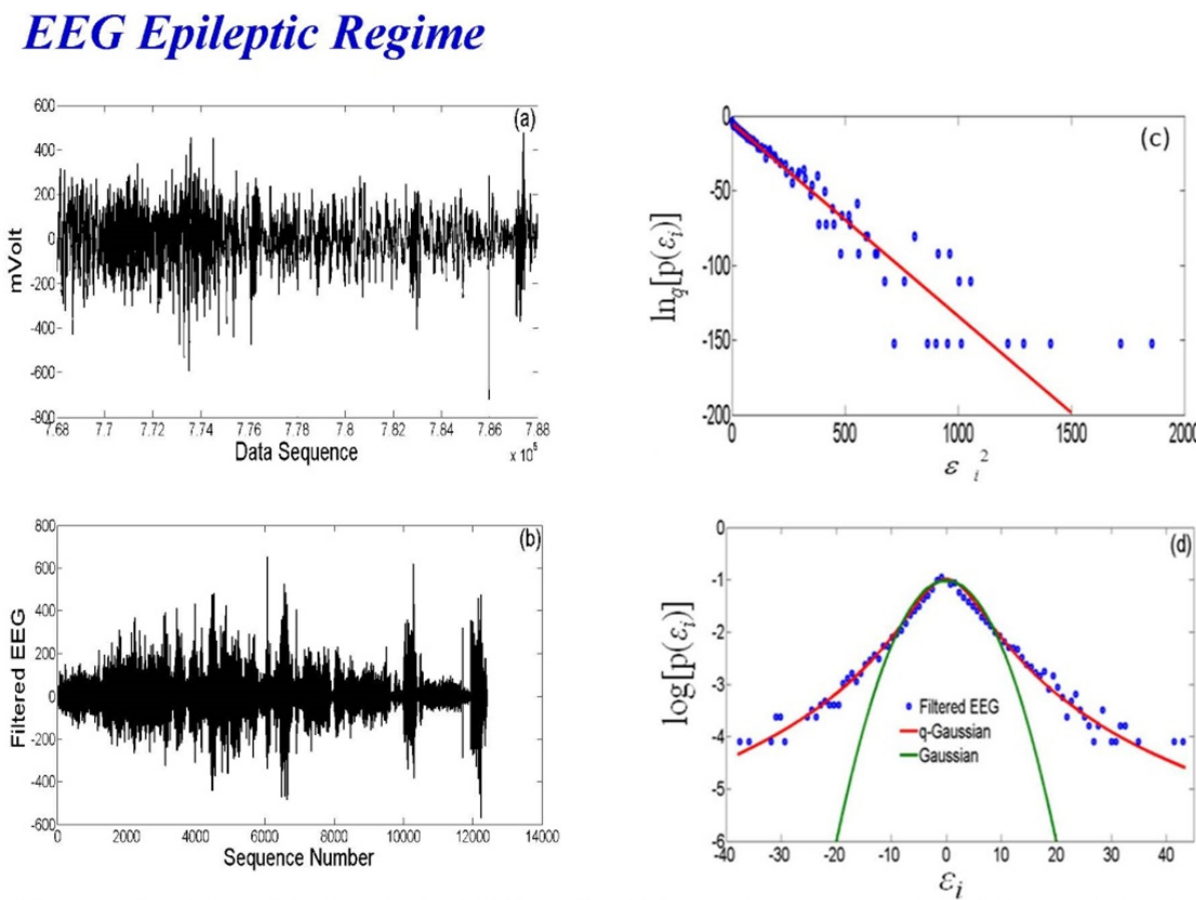
Figure 9: a) Time series of epileptic episode. b) Filtered EEG time series corresponding to a) . c) Best linear correlation between ln q [ p ( ε i )] and ε 2 for the filtered signal. d) log[ p ( s )] vs s for the filtered EEG time series (blue circles), the theoretical q-Gaussian (blue line) and the i i i normal Gaussian (green line).